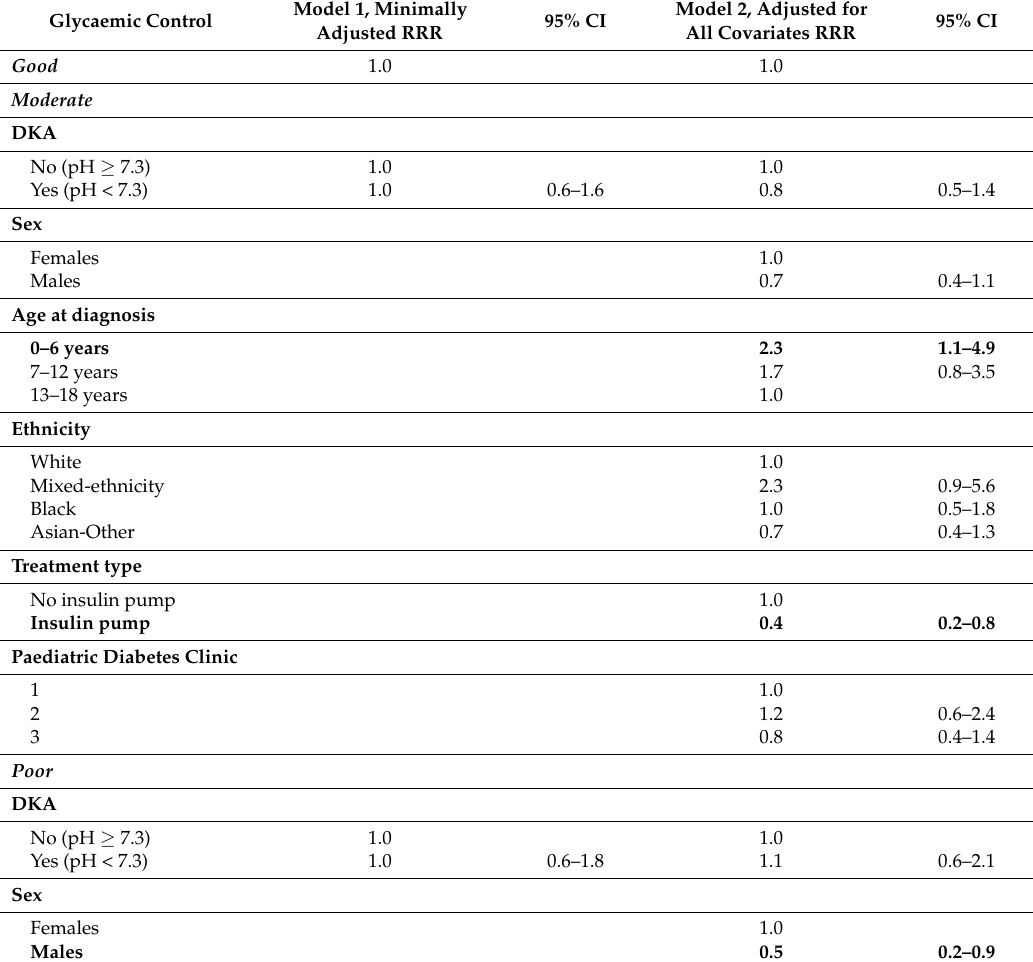
Table 4. Relative risk ratios (RRR) associated with moderate (HbA1 c 58–79 mmol/mol) and